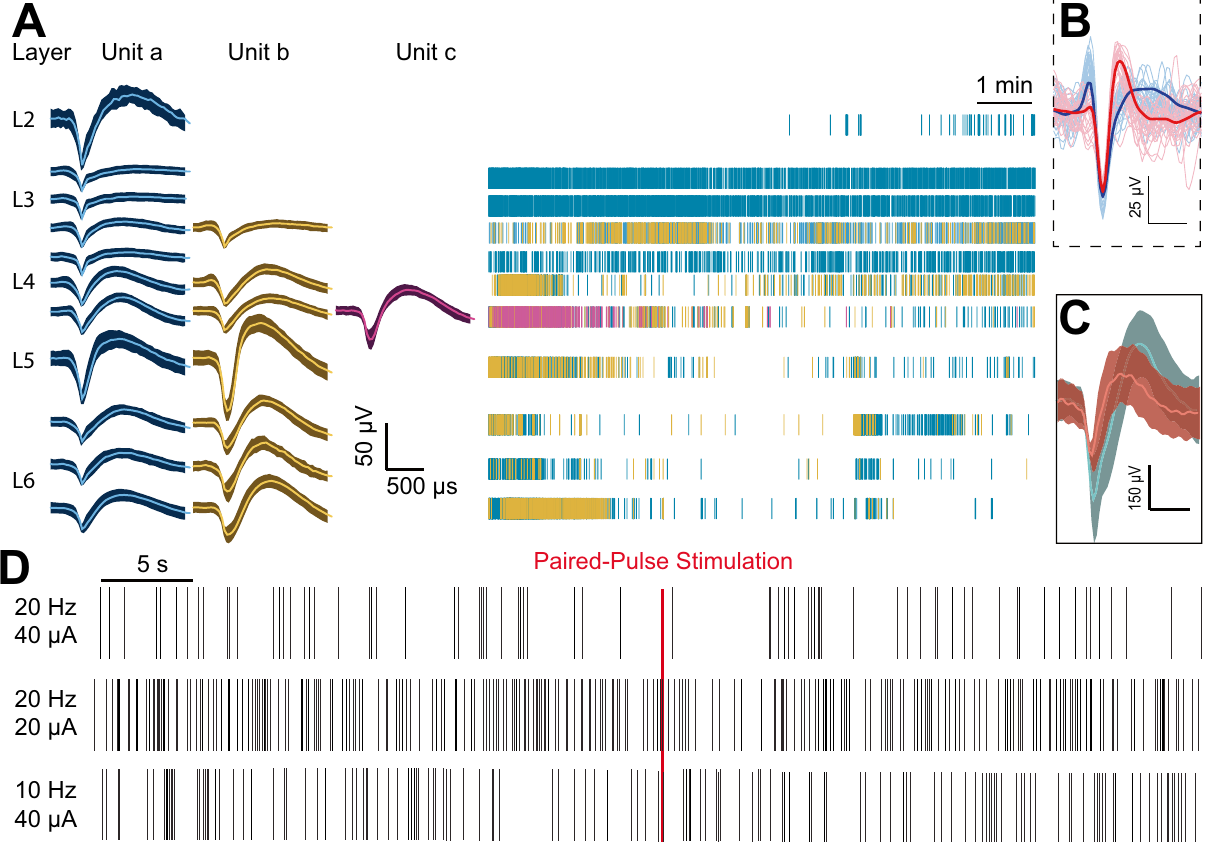
Figure 7. Intracortical recordings. Single-units (i.e., single neuron activities) were recorded across cortical depth. ( A ) Left: Waveforms of up to 3 single-units isolated in a depth-recording using a standard microelectrode array (scale bars = 50 µV and 500 µs). Right: Spike-raster with colors matching single-units on the left (scale bar = 1 min). ( B ) Dotted inset: An example of a narrow-spike (pink) and broad-spike (blue) single-unit (scale bars = 25 µV and 500 µs). Dark lines reflect the average waveform. ( C ) Examples of waveforms isolated from intracortical depth-recordings using amorphous silicon carbide (a-SiC) ultrasmall microelectrode arrays (scale bars = 150 µV and 500 µs). ( D ) Spiking activity during baseline and after paired-pulse stimulation using different pulse frequencies and current amplitudes (scale bar = 5